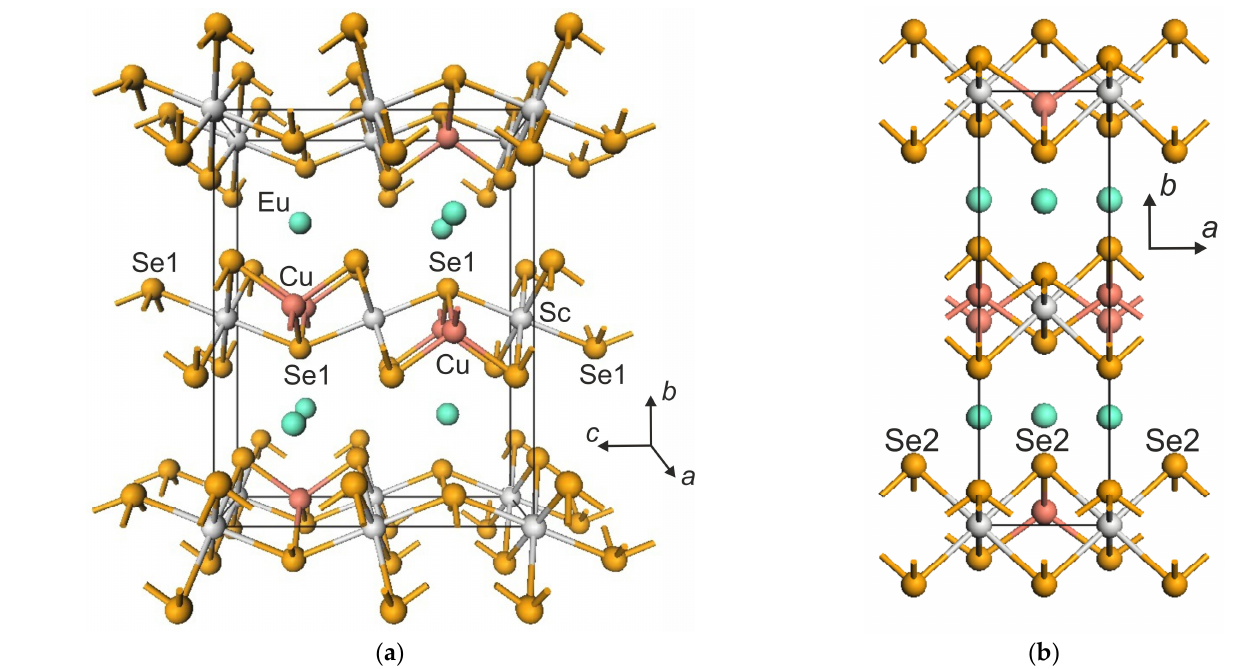
Figure 2. Orthorhombic crystal structure of EuScCuSe 3 : ( a ) Perspective view of the extended unit cell perpendicular onto the bc plane, ( b ) projection onto the ab plane. cell perpendicular onto the bc plane, ( b ) projection onto the ab plane.